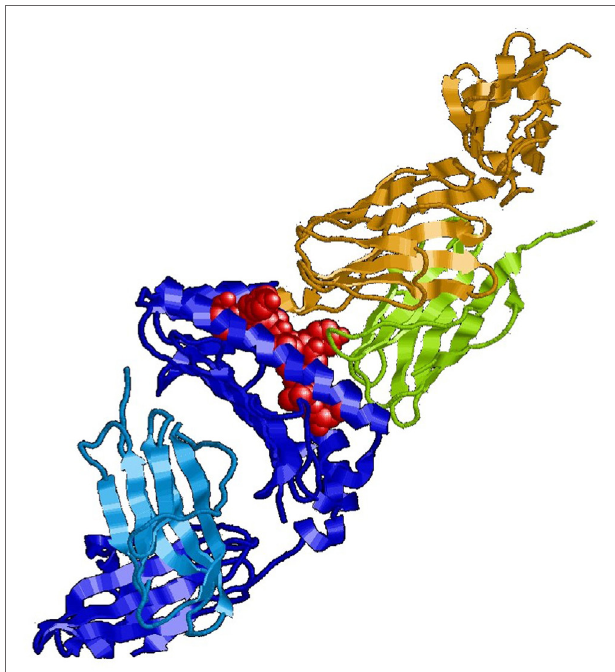
FiGUre 2 | MHC class i molecule (blue) presenting a peptide (red) to the t-cell receptor (green/olive) . For review, see Ref. (10).